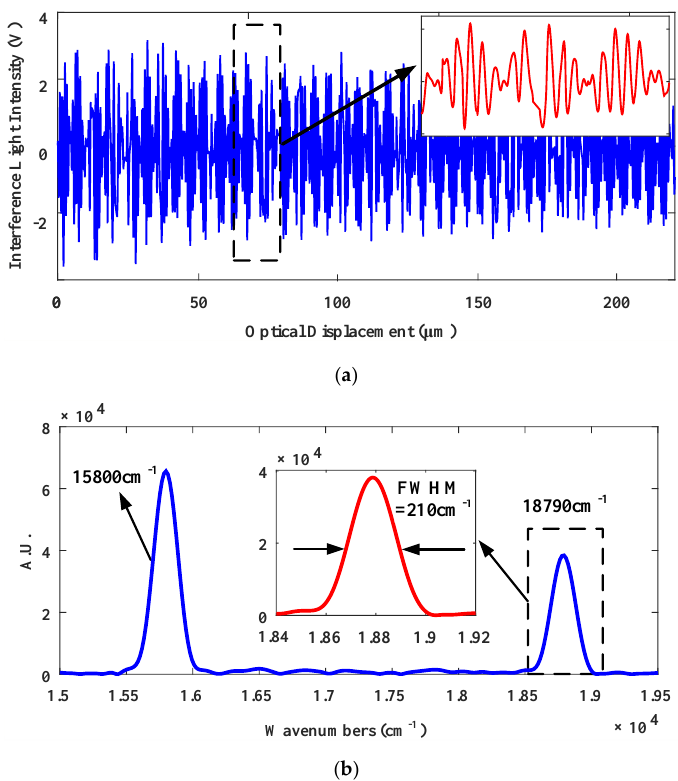
Figure 18. Under look-up table control using the same driving as PID control ( a ) The reconstructed interferogram of the testing light in spatial domain testing light. ( b ) Spectrum recovered of the testing light.